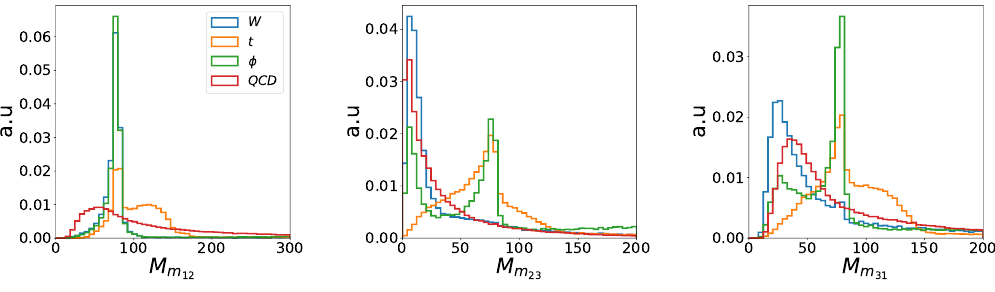
Figure 2 . Similar to figure 1, but showing the normalised invariant mass distribution between three leading microjets in the fat